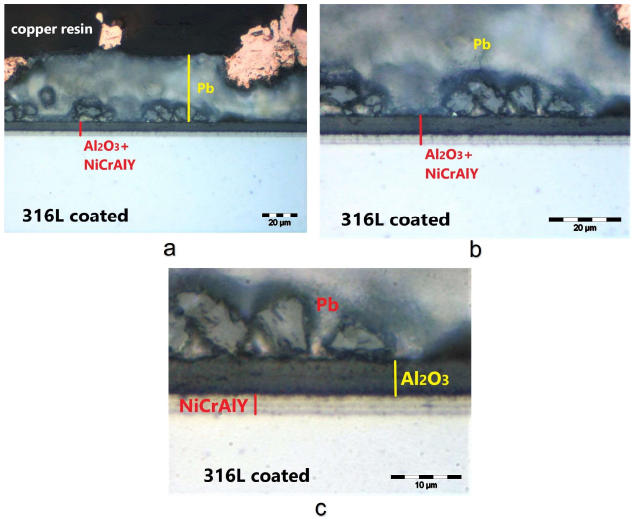
Figure 14. Cross section of the AISI 316L coated specimen after being tested for 1000 h in liquid lead at different magnifications: 500× ( a ), 1000× ( b ), and 2000× ( c ).